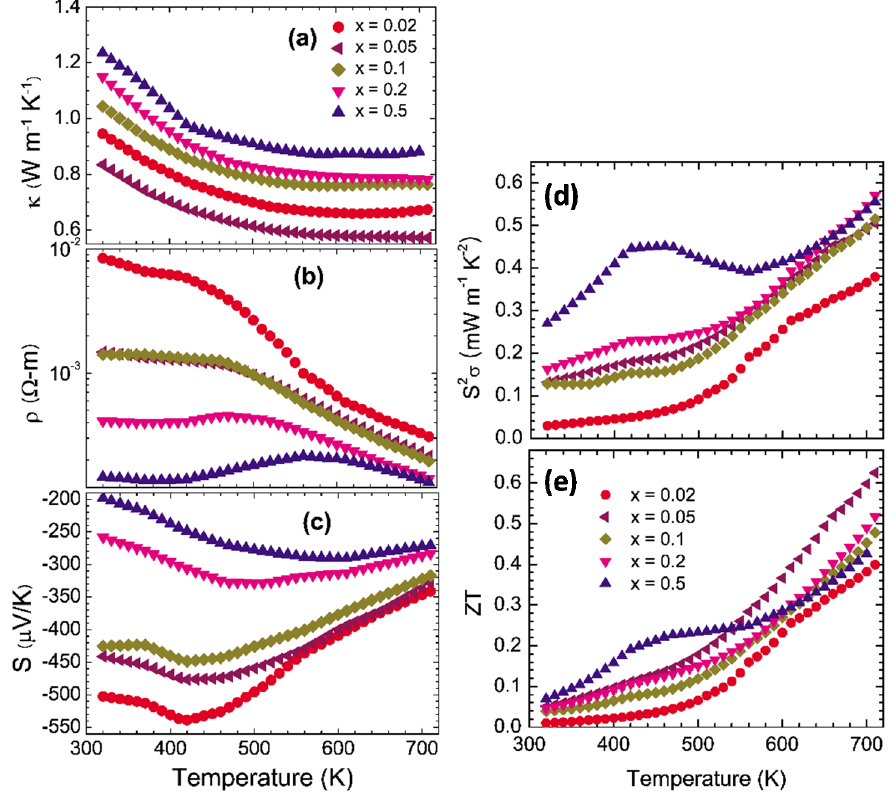
Figure 3. Thermoelectric properties of polycrystalline In 4 Se 3 −δ ( δ = 0.02, 0.05, 0.1, 0.2, and 0.5). ( a ) Thermal conductivity, ( b ) Electrical resistivity, ( c ) Seebeck coefficient, ( d ) Power factor, and ( e ) Dimensionless figure-of-merit. Reproduced with permission from AIP Publishing LLC, 2009